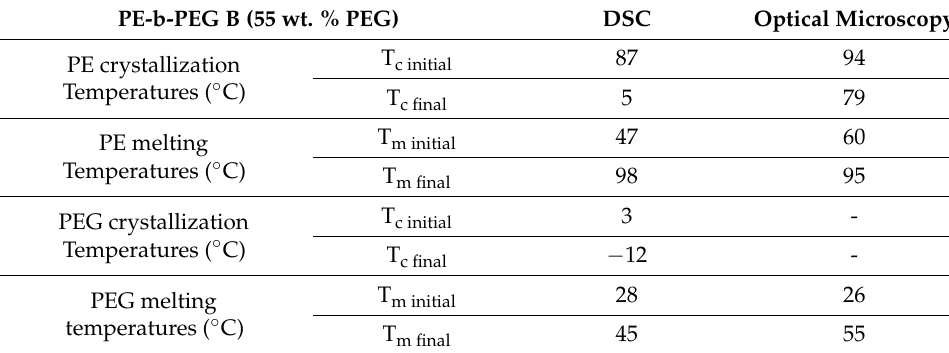
Table 6. Comparison of the melting and the crystallization temperatures of PE and PEG blocks in PE-b-PEG B obtained by optical microscopy and DSC.